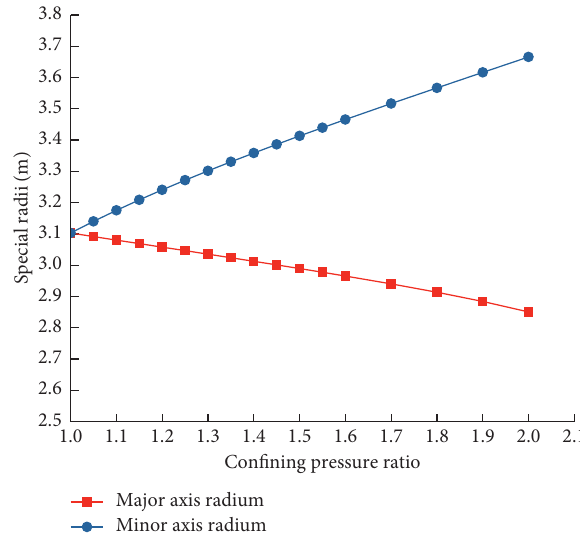
Figure 7: The relationship between special radii and confining pressure